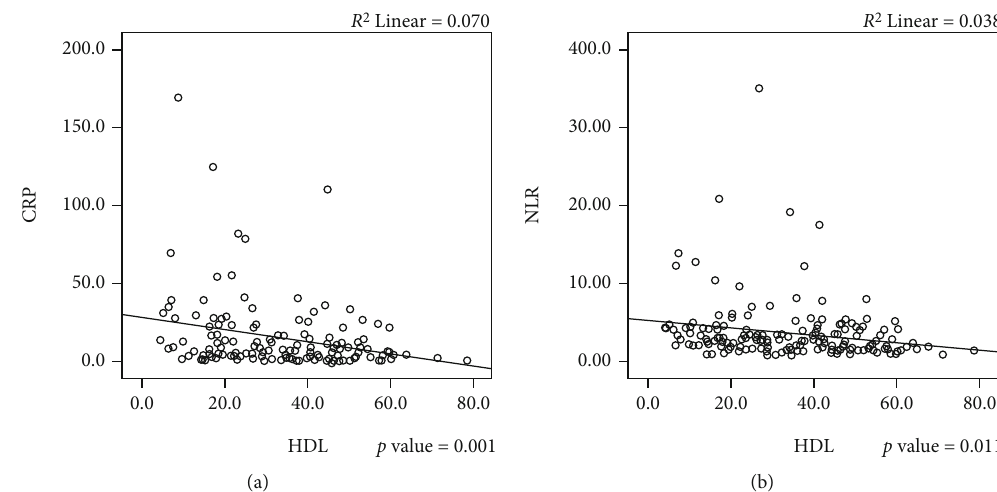
Figure 2: HDL-C levels showing a signi fi cant linear inverse correlation with markers of systemic in fl ammation: (a) correlation of HDL-C levels with CRP values ( p value 0.001). (b) Correlation of HDL-C levels with NLR ( p value 0.011). ∗ Abbreviations: HDL-C: high-density lipoprotein cholesterol; CRP: C-reactive protein; NLR: neutrophil-lymphocyte